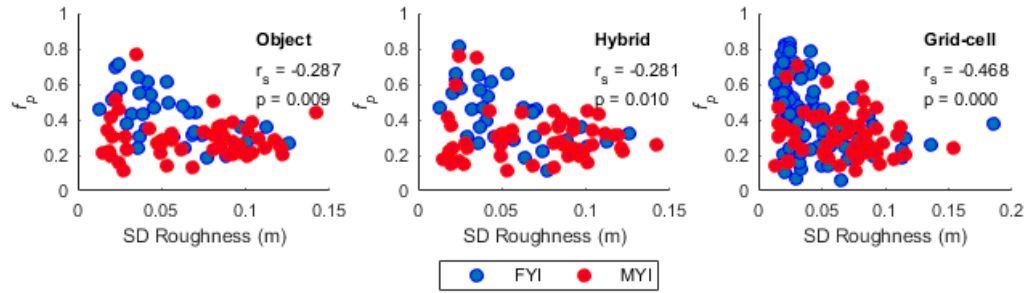
Figure 9. Scatter plots of f p as a function of standard deviation of roughness at the medium scale using object ( left ), hybrid object ( middle ) and 240 m grid-cell ( right ) aggregation approaches. Spearman correlation coefficients (r s ) and corresponding p -values are shown for pooled FYI and MYI data.